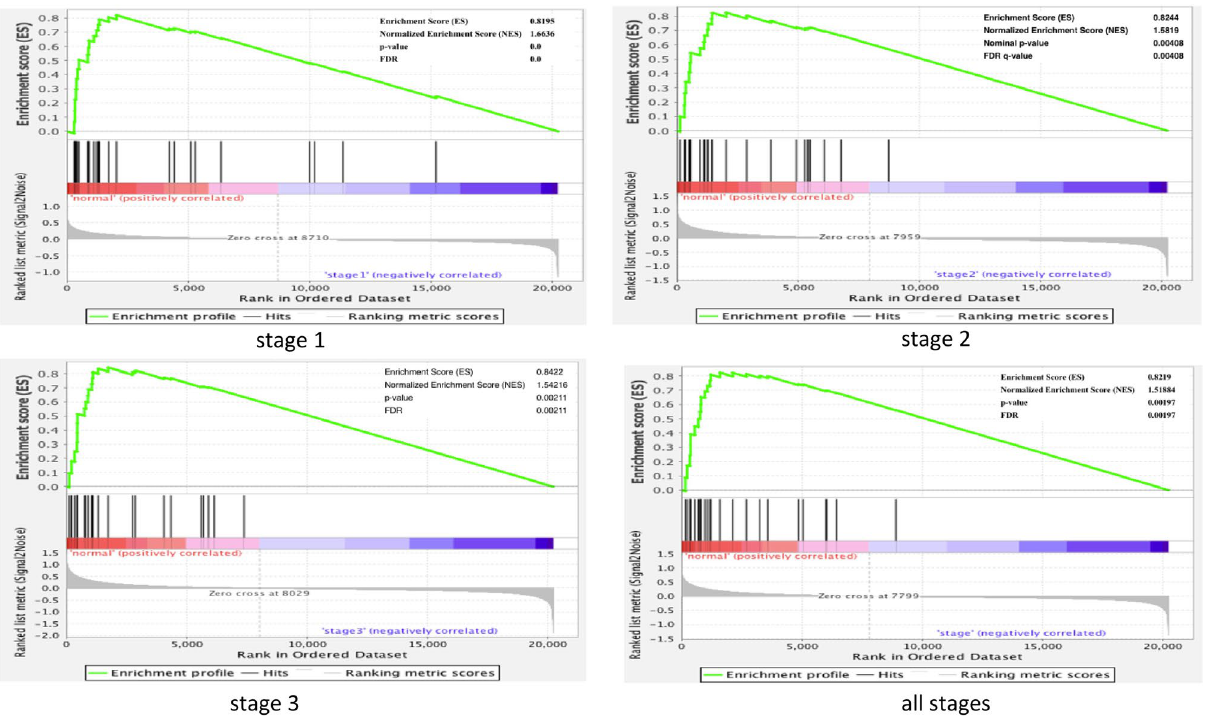
Figure 8. GSEA analysis of TS genes. GSEA plot shows profile of the running ES scores & positions of GeneSet members on the rank ordered List of genes. 26 TS genes were setup as a gene set, samples from Taiwan female NSCLC cohort were used as phenotype data and Human_AFFY_HG_U133_ MSigDB.v7.1.chip was used as annotation file. GSEA analysis was respectively performed on microarray datasets at stages 1, 2, 3 and all stages. Permutation was performed among samples for 1000 times for calculating p-value. FDR is used for multiple tests 38 . Stage 1: 38 normal samples and 15 cancer samples. Stage 2: 38 normal samples and 11 cancer samples. Stage 3: 38 normal samples and 7 cancer samples. All stages: 38 normal samples and 38 cancer